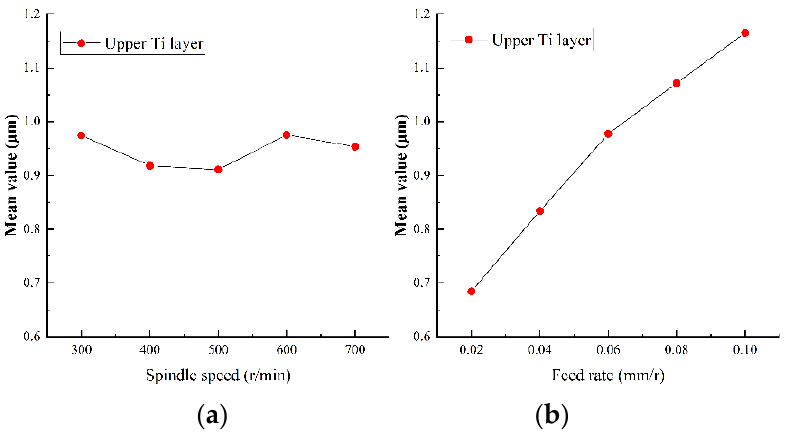
Figure 14. Main effect plots of surface roughness of hole wall for drilling upper titanium alloy in ( a ) spindle speed and ( b ) feed rate.